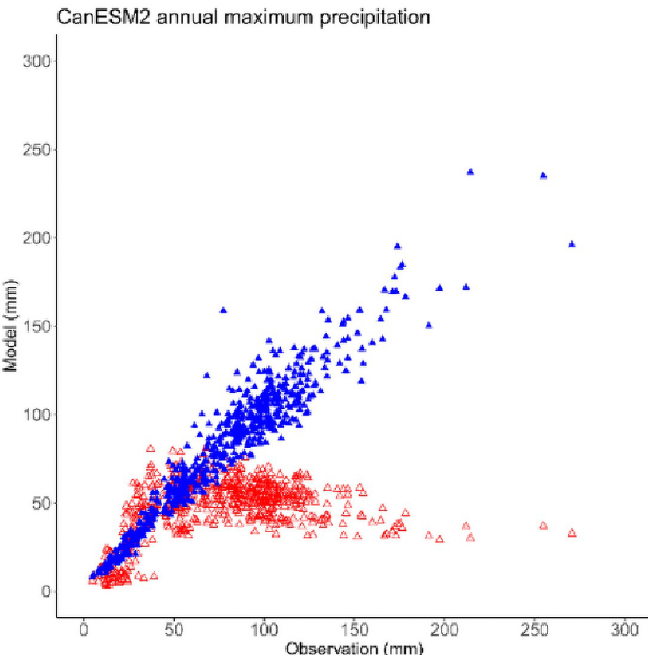
Fig 2. The correction between the observation data and CanESM2 modeling of annual maximum precipitation. The red triangle represents the raw ensemble and the blue triangle represents the bias-corrected ensemble.